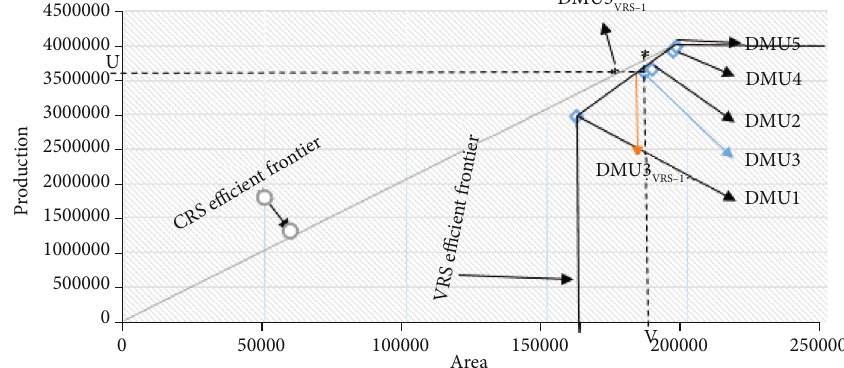
Figure 4: The results of the CRS and VRS e ffi ciency